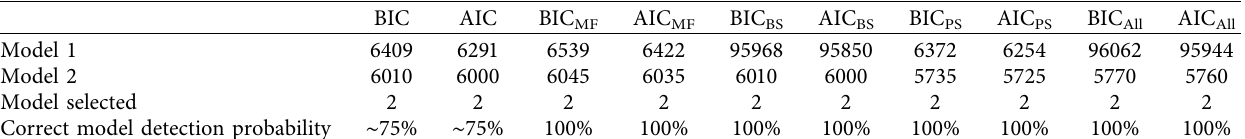
Table 3: Estimates of the various versions of the indicators for the regressor example of equations (15)–(17).